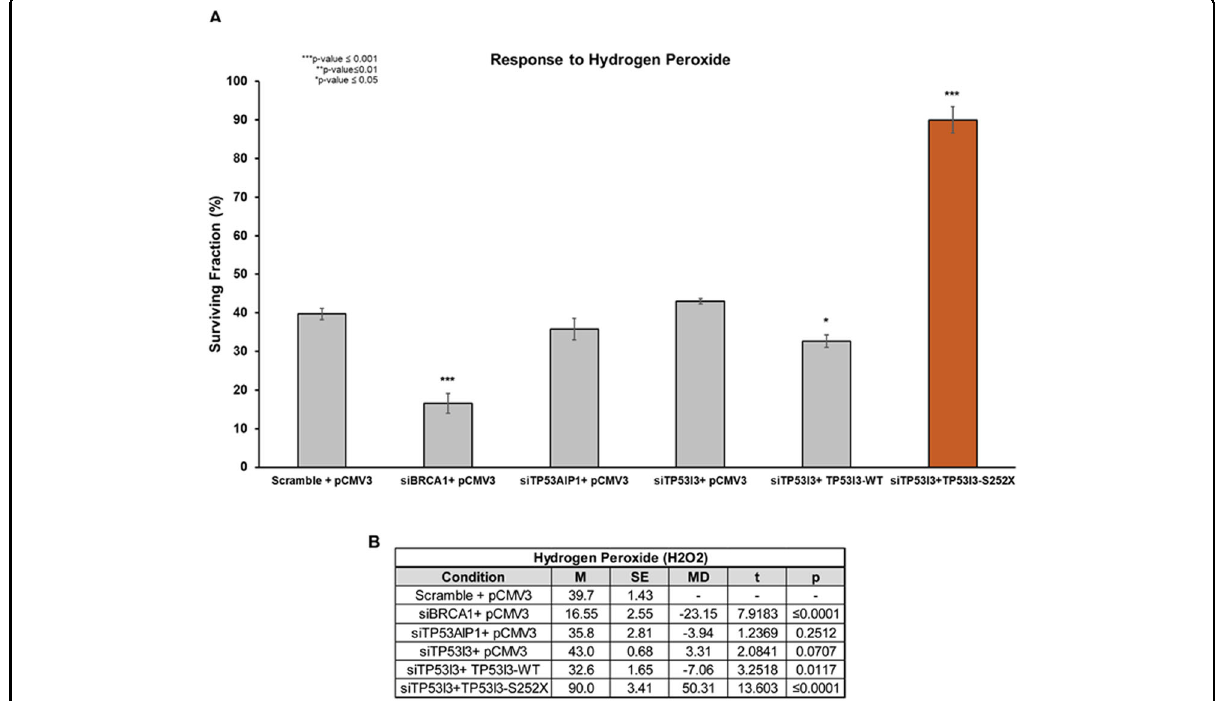
Fig. 6 Response of TP53I3-S252X-bearing cells to oxidative stress. A Surviving fraction after treating cells with H 2 O 2 in terms of plating ef fi ciency. B Calculated two-way t test for H 2 O 2 -conditioned cells compared with scramble-positive control. With an n = 5, p values ≤ 0.05 were considered statistically signi fi